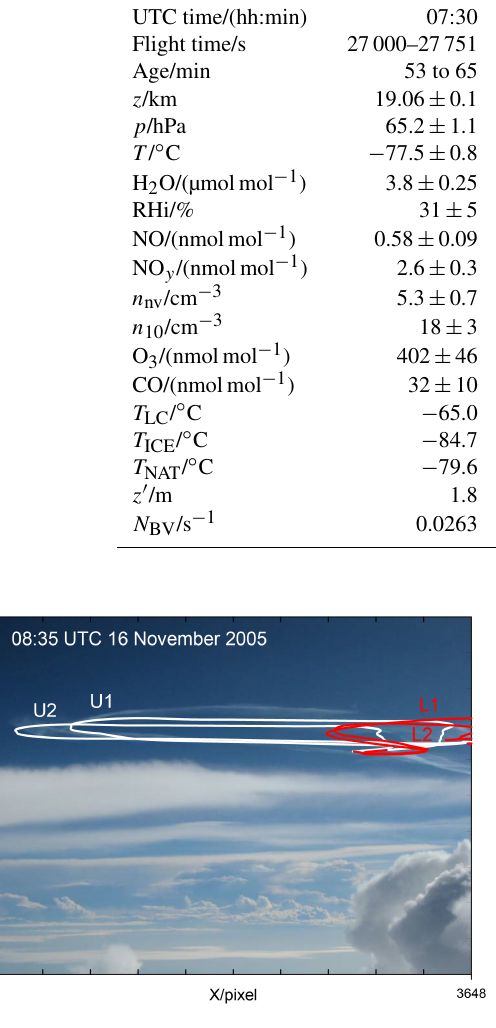
Figure 5. Computed contrail positions overlaid over the photo shown in Fig. 1 (08:35UTC, 16 November 2005). The coordinates count the number of photo pixels. The pair of computed contrail lines (U and L, upper and lower) is derived from plume advection with (U2, L2) and without (U1, L1) wake descent. The line colors (white/red lines) denote the upper/lower contrail parts separated at 18km altitude. The lower contrail reaches below the